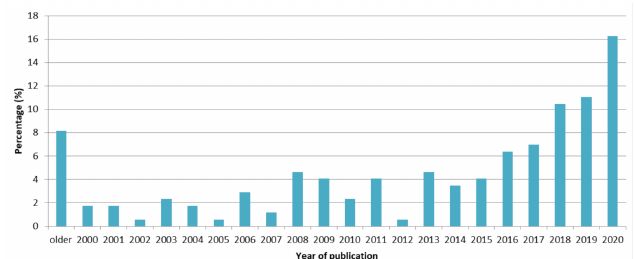
Figure 1. Reviewed studies according to the year of publication.